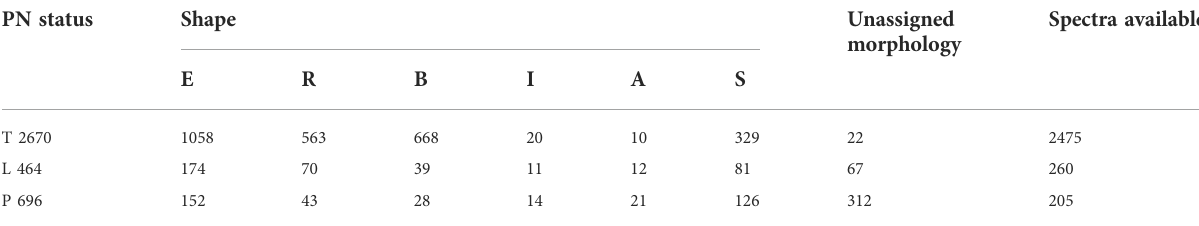
TABLE 1 Breakdown of all HASH T (true), L (likely) and P (possible) PNe by base morphological type (shape) and the number of spectra available for eachstatus.ThesebasetypesareE:Elliptical/oval,R:Round,B:Bipolar;I:Irregular;A:Asymmetric;S:Star-like/compactorapparentpointsource. PN status Shape